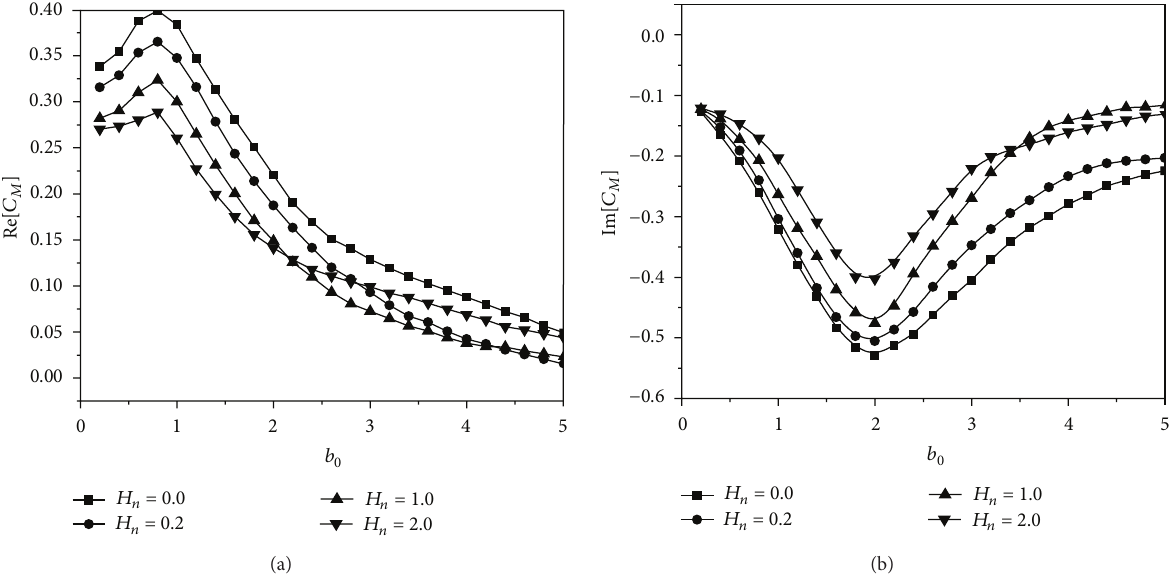
Figure 3: The dynamic compliance coefficient 𝐶 𝑀 of different single-phase elastic layer thicknesses ( 𝐻 𝑛 ). (a) Real part of 𝐶 𝑀 versus the dimensionless frequency and (b) imaginary part of 𝐶 𝑀 versus the dimensionless